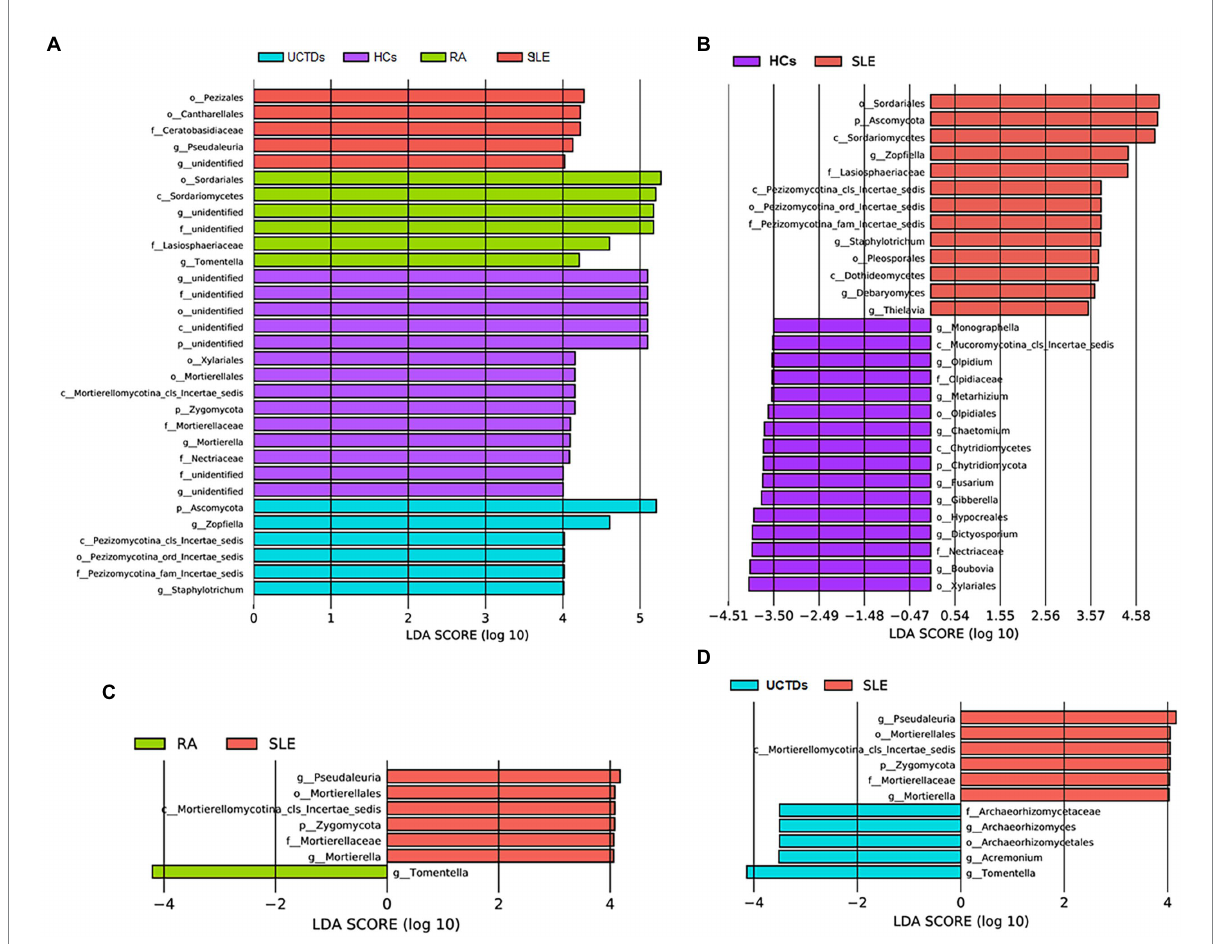
FIGURE 2 Taxonomic differences in fungal composition between SLE, RA, UCTDs and HCs by LEfSe analysis. (A) Taxonomic differences in fungal composition between SLE, HCs, RA and UCTDs; (B) taxonomic differences in fungal composition between SLE and HCs; (C) taxonomic differences in fungal composition between SLE and RA; (D) taxonomic differences in fungal composition between SLE and